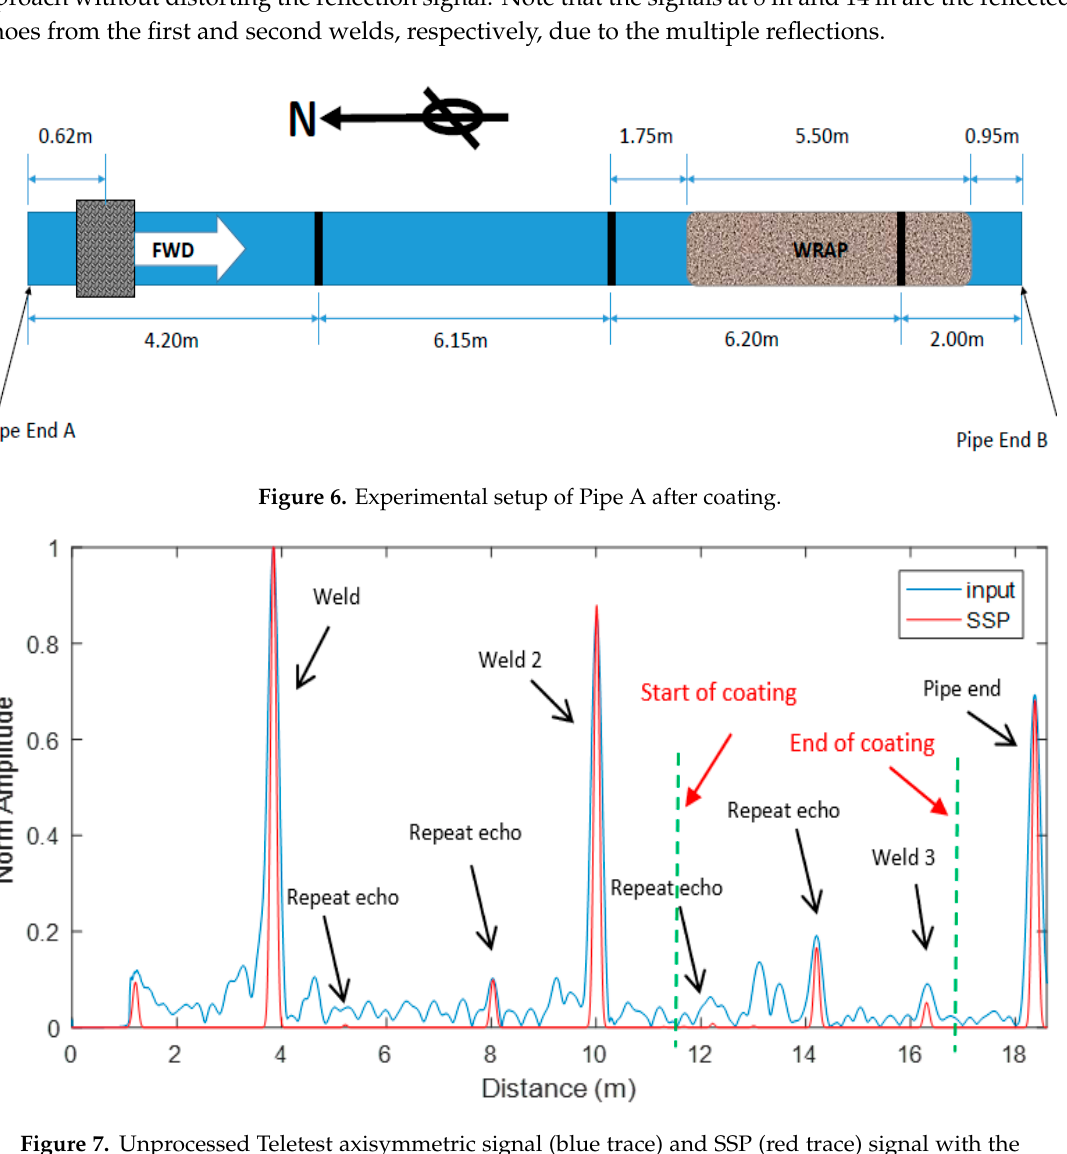
Figure 6. Experimental setup of Pipe A after coating.